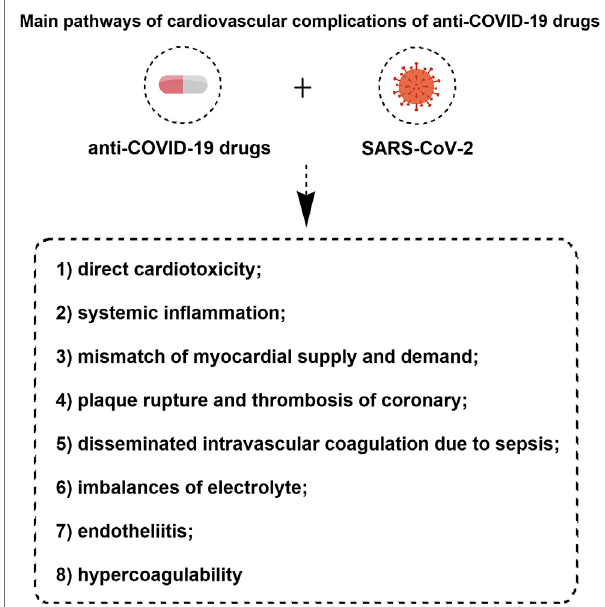
FIGURE 2 | The main pathways of cardiovascular complications of anti- COVID-19 drugs.